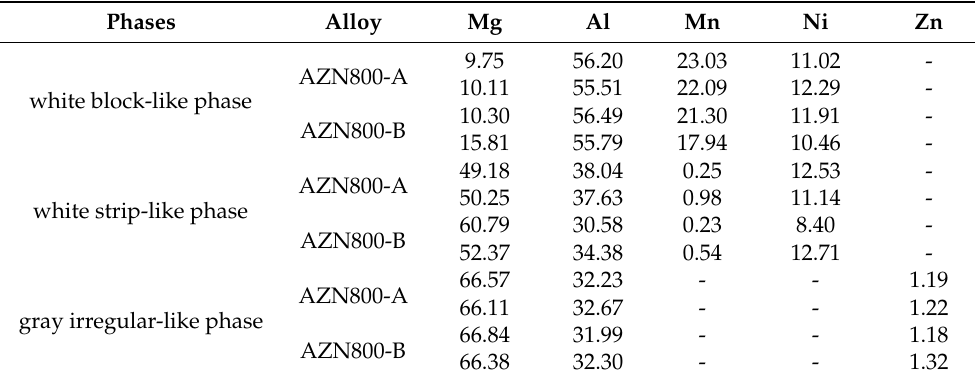
Table 1. The EDS results of the AZN800-A and AZN800-B alloys